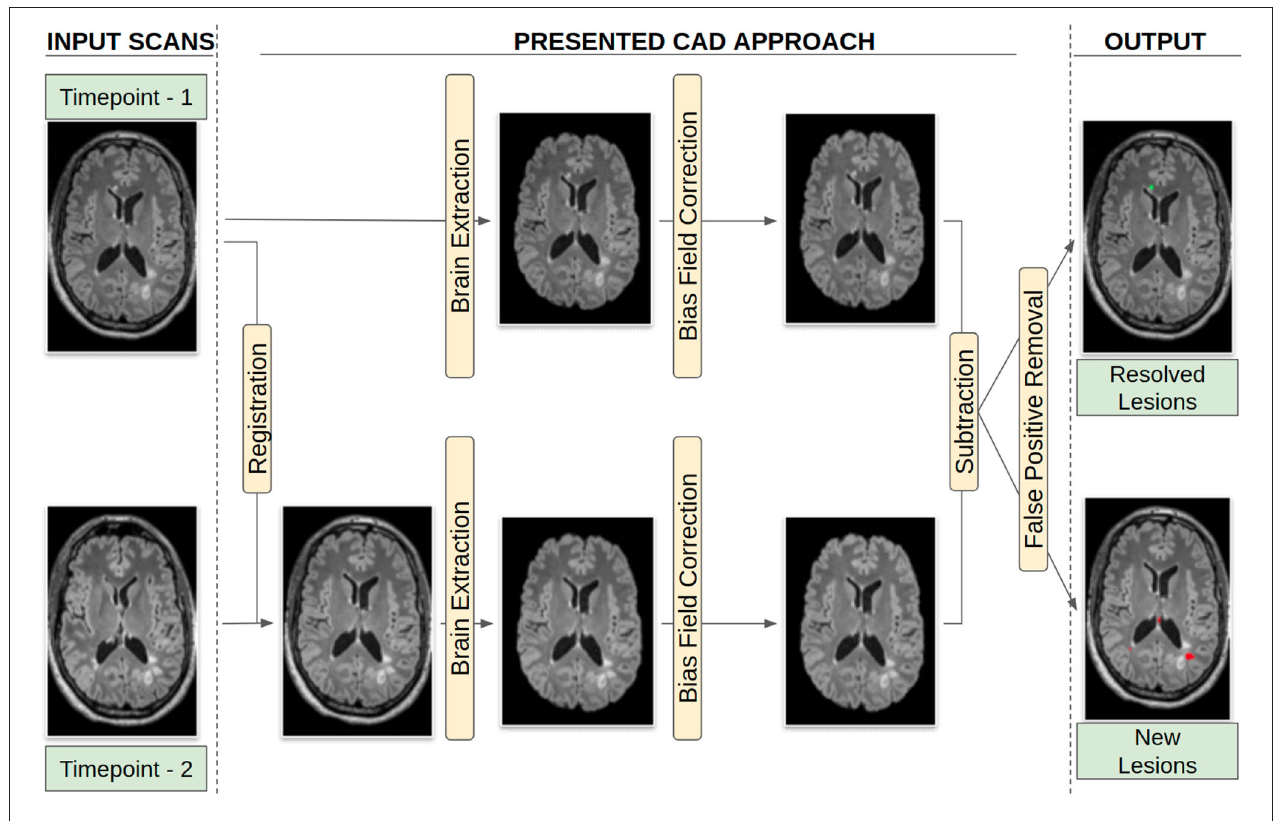
FIGURE 2 | Workflow followed for generating the lesion maps.